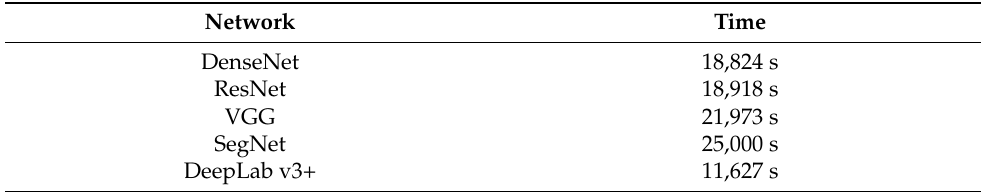
Table 2. Training time of the DenseNet, ResNet, VGG, SegNet and DeepLab v3+ models.